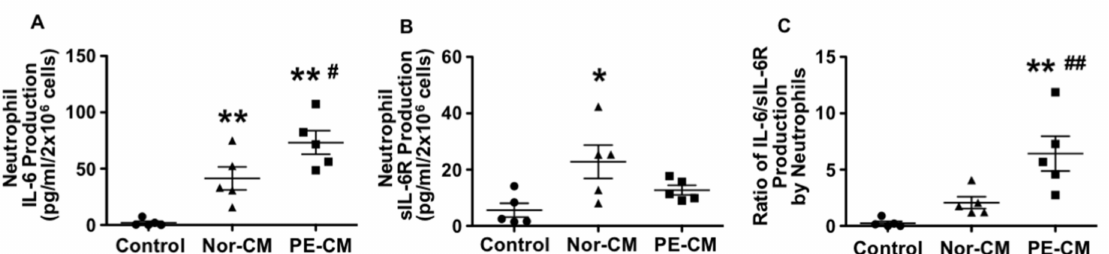
Figure 2. Neutrophil production of IL-6 and sIL-6R after primed by normal and PE placental conditioned medium (CM). Neutrophils produced more IL-6 ( A ) but less sIL-6R ( B ) after being primed by PE-CM compared to cells primed by normal- CM. The ratio of IL-6 to sIL-6R production was significantly increased in cells treated with PE-CM ( C ). * p < 0.05 and ** p < 0.01: cells primed with CM vs. control; # p < 0.05 and ## p < 0.01: cells primed with PE-CM vs. normal-CM. Data are represented from five independent